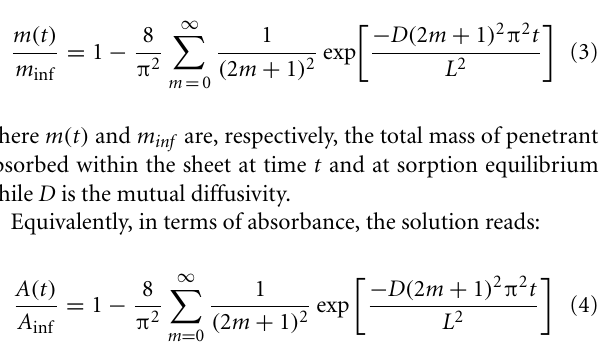
where L represents the thickness of the plane sheet. For this con- figuration, the solution of the second Fick’s law is (Crank, 1975):